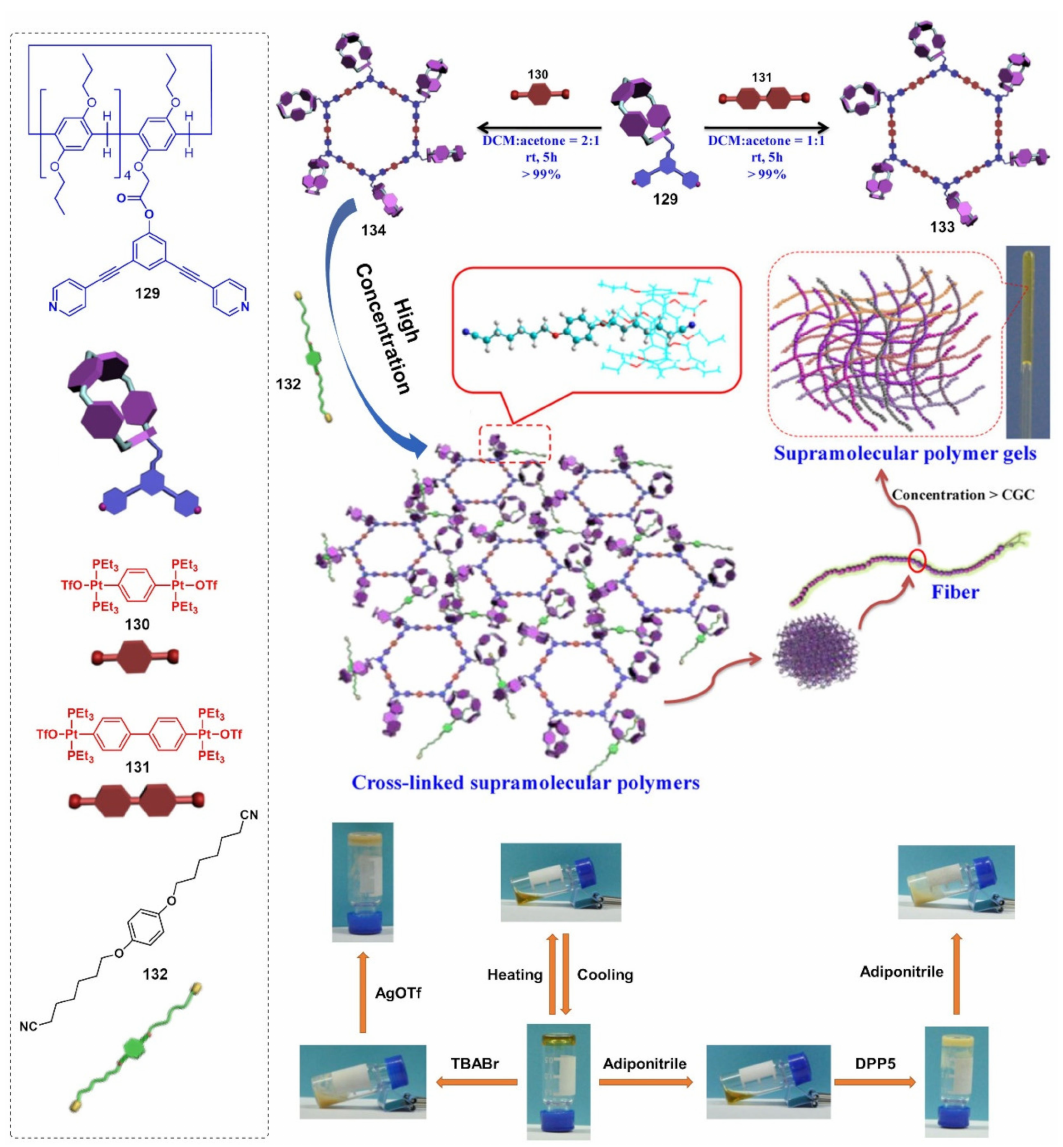
Figure 53. Schematic representation of the hexagonal macrocyclic assembly, the formation of supramolecular polymer gels, and reversible gel–sol transitions of supramolecular polymer gels. Reprinted with permission from Ref. [135]. Copyright (2014), American Chemical